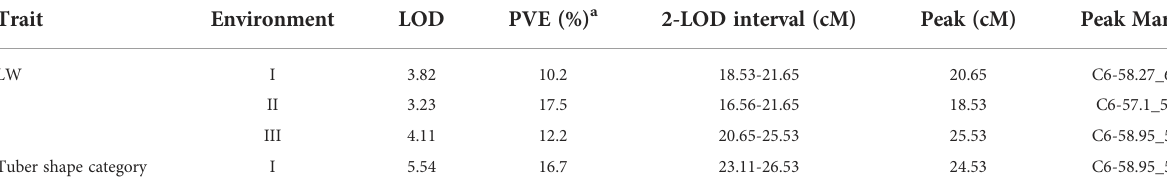
TABLE 3 The QTL Tscha6 detecting for tuber shape by Multiple-QTL Models. Trait